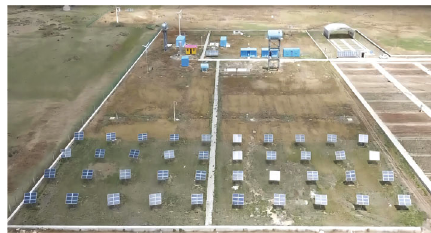
Figure 8: Photovoltaic panel site array